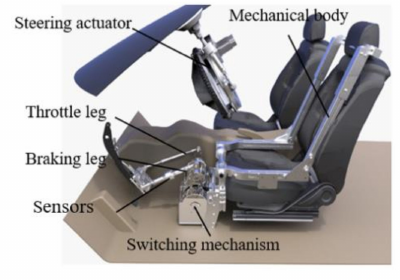
Figure 5. The developed automated driving robot.